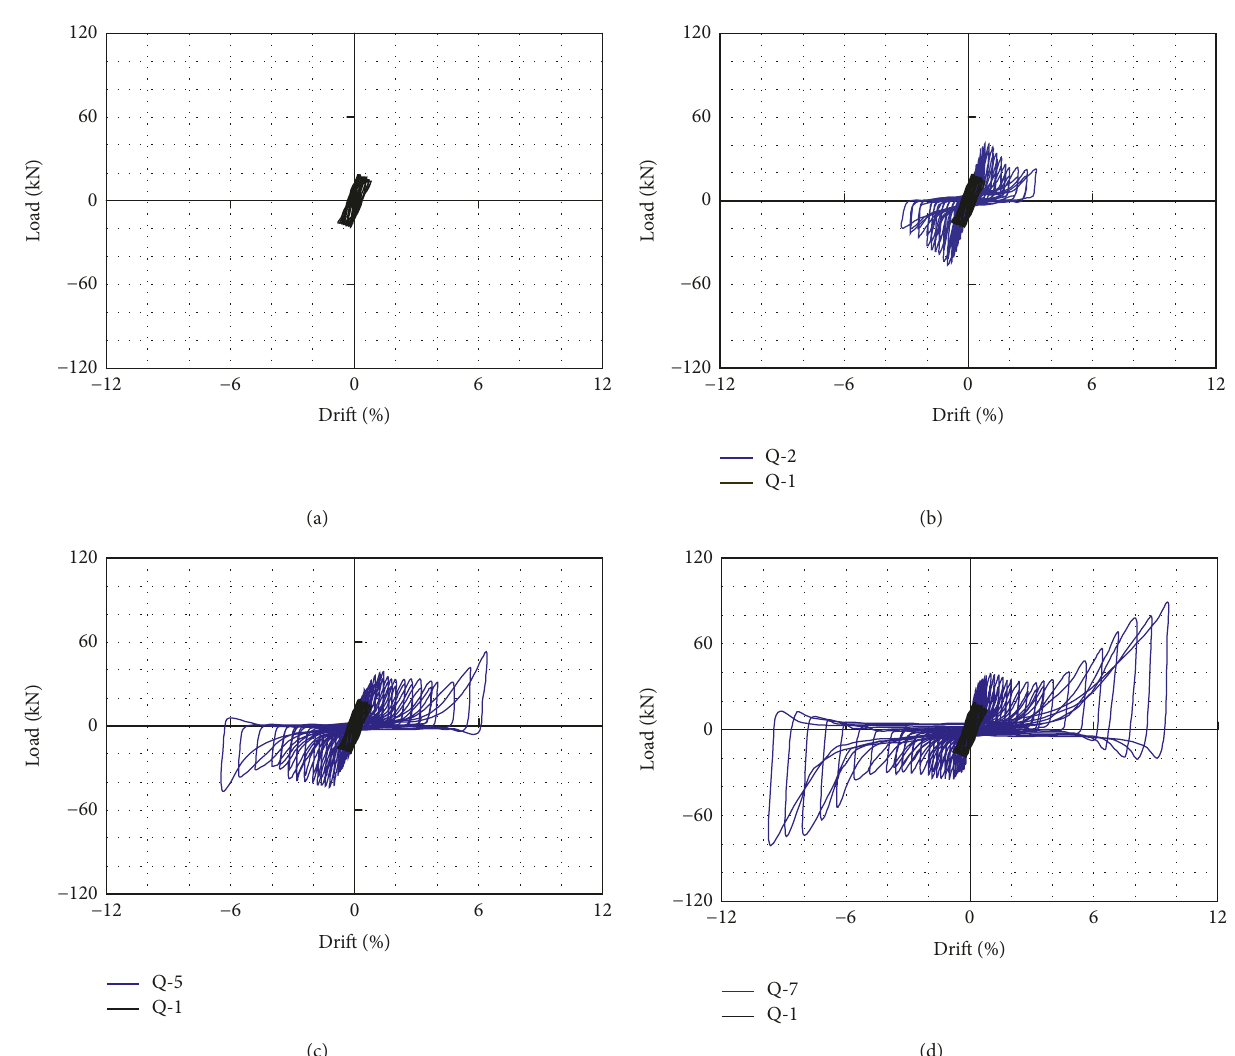
Figure 8: Hysteresis curves of specimens. The hysteretic response of (a) Q-1; (b) Q-1 and Q-2; (c) Q-1 and Q-5; (d) Q-1 and Q-7.